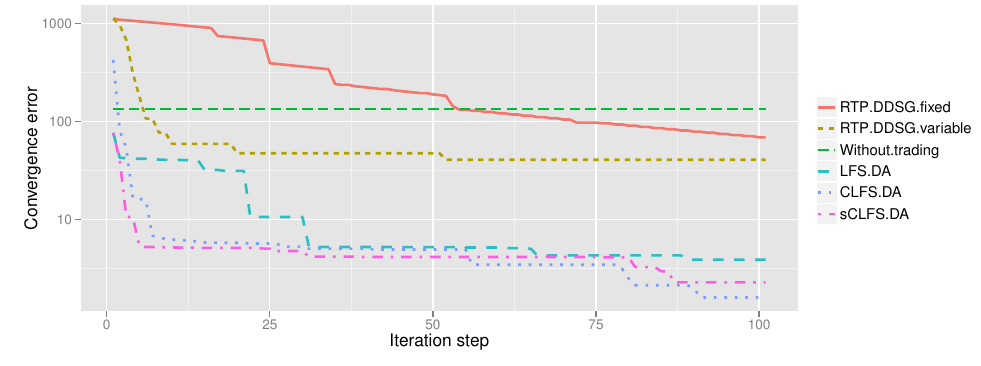
Figure 4. Convergence error after iterations with each